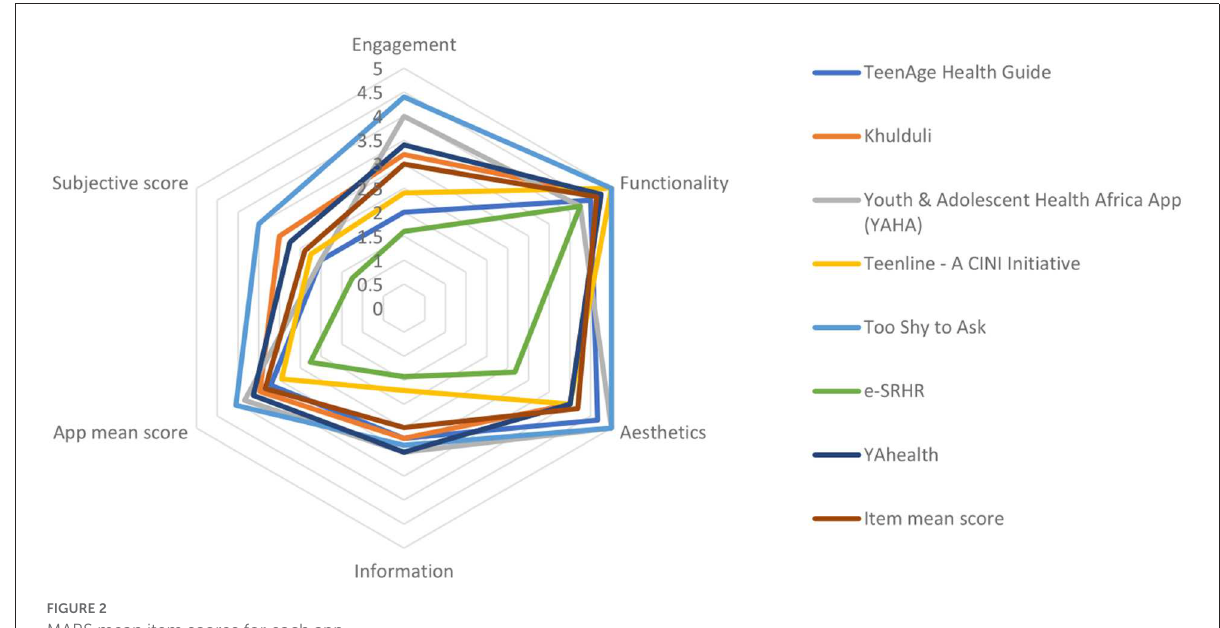
FIGURE2 MARS mean item scores for each